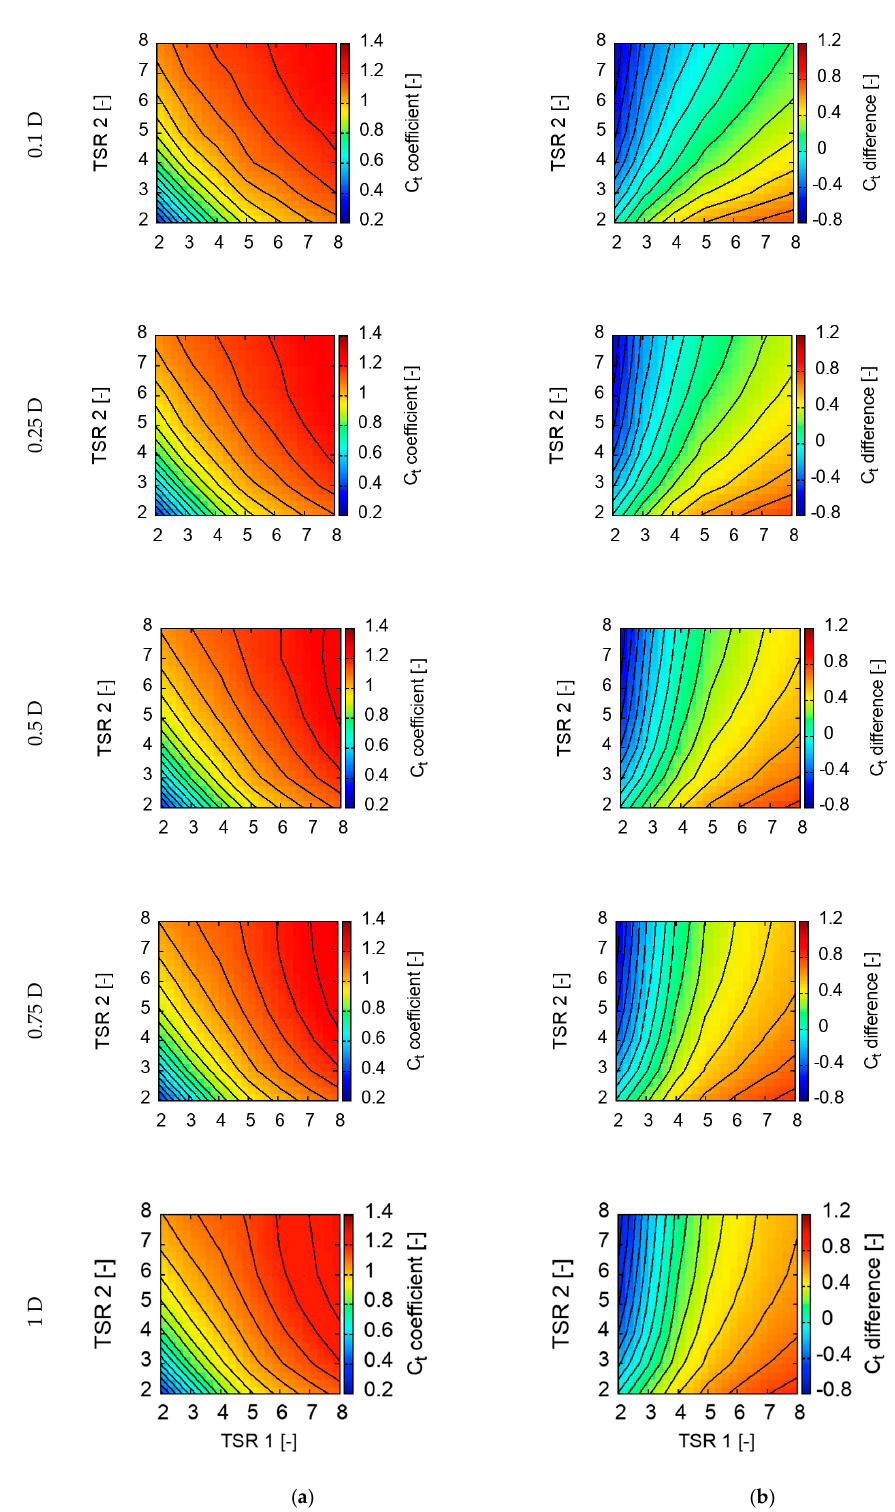
Figure 8. Maps of total thrust coefficient C t ( a ) and the difference in C t between rotors ( b ).